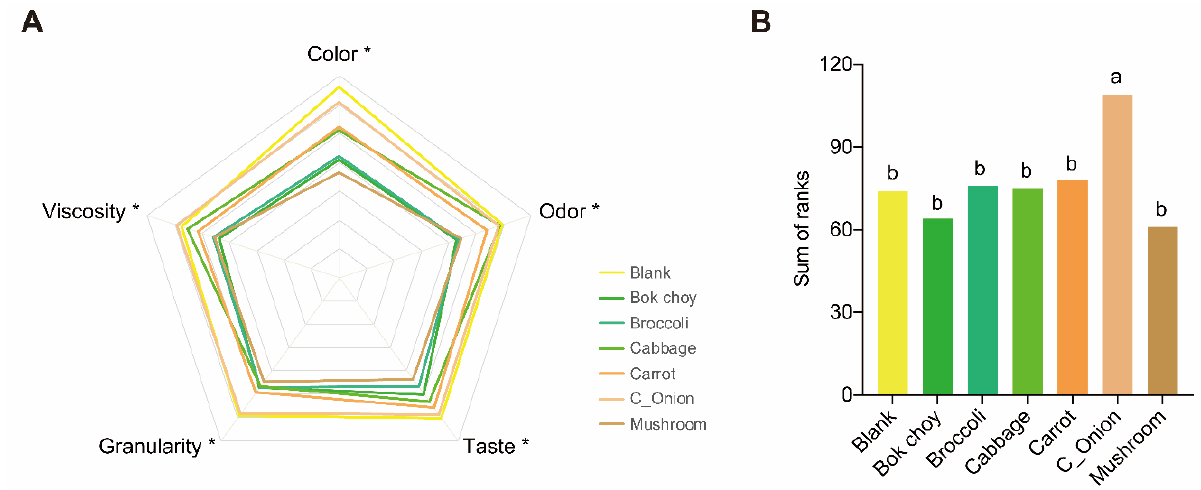
Figure 6. Caregiver evaluation and Preference ranking of differently fortified ugali . ( A ) caregiver evaluation of differently fortified ugali . * indicates significant difference between fortified ugali and plain ugali . ( B ) preference ranking of differently fortified ugali , different letters indicate significance between differently fortified ugali .